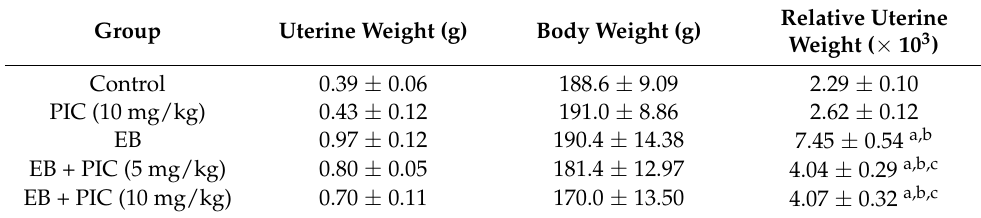
Table 2. Effect of PIC SNEDDS (5 and 10 mg/kg) on uterine weight in EB-induced EH in rats.